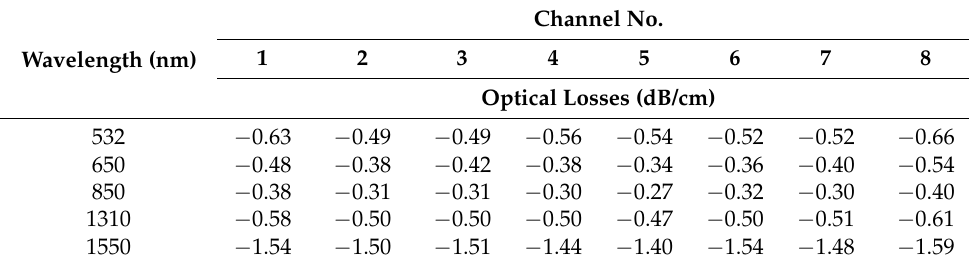
Table 2. Optical losses for sample #6 measured by the cut-back method at wavelengths 532, 650, 850, 1310 and 1550 nm.